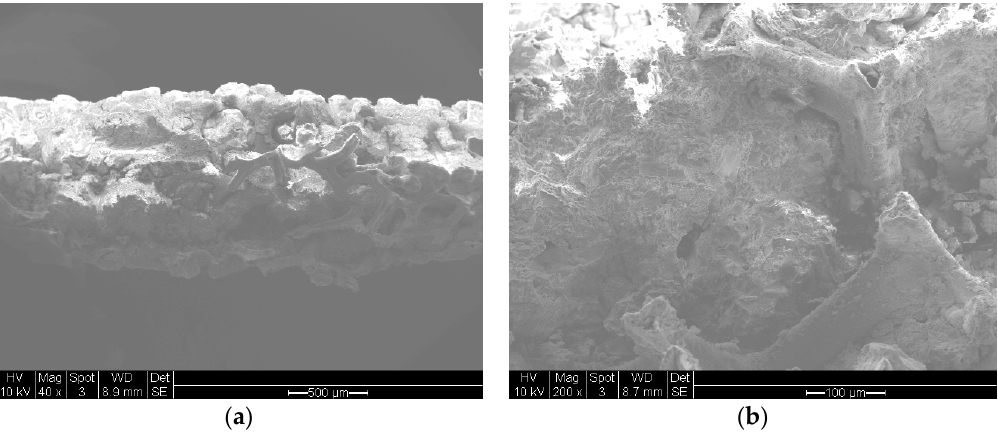
Figure 7. Scanning electron microscopy of silica supported cobalt catalyst macro ‐ porous nickel foam. ( a ) Overall appearance of the fracture surface of the foam with catalyst (scale bar = 500 μ m); ( b ) At large magnification showing the walls of the nickel foam in a large pore with the porous supported catalyst. (scale bar = 100 μ m).